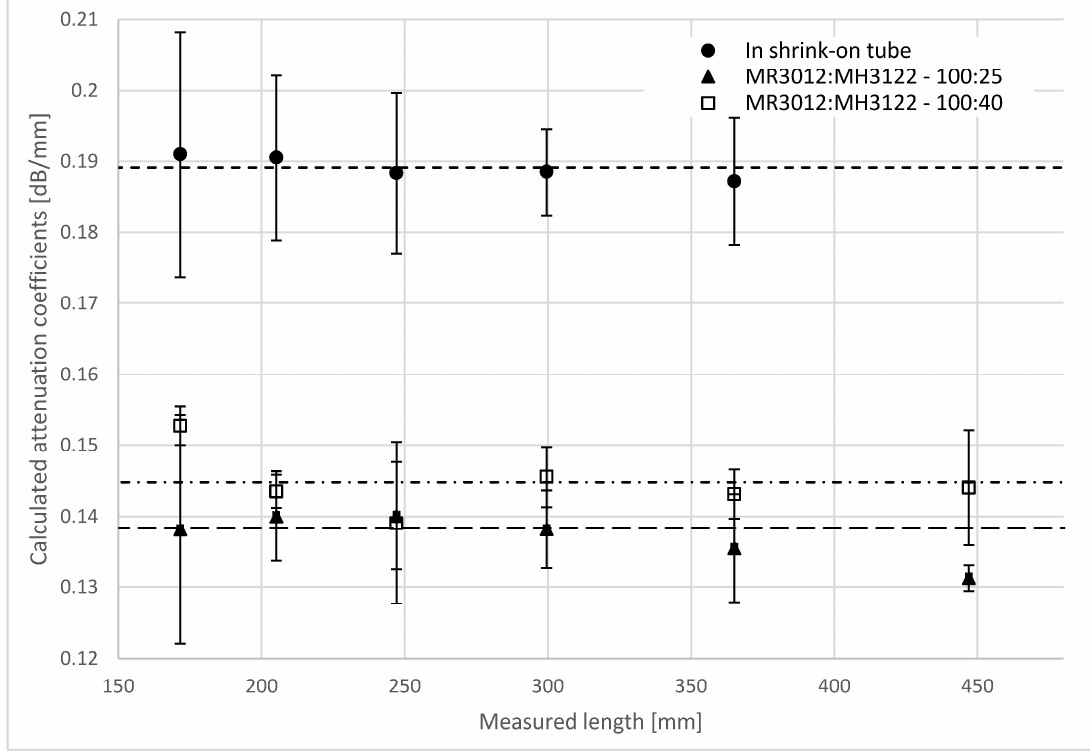
Figure 6. The attenuation coefficients of the reinforcing glass fiber bundles at room temperature and with a 532 ‐ nm light source.